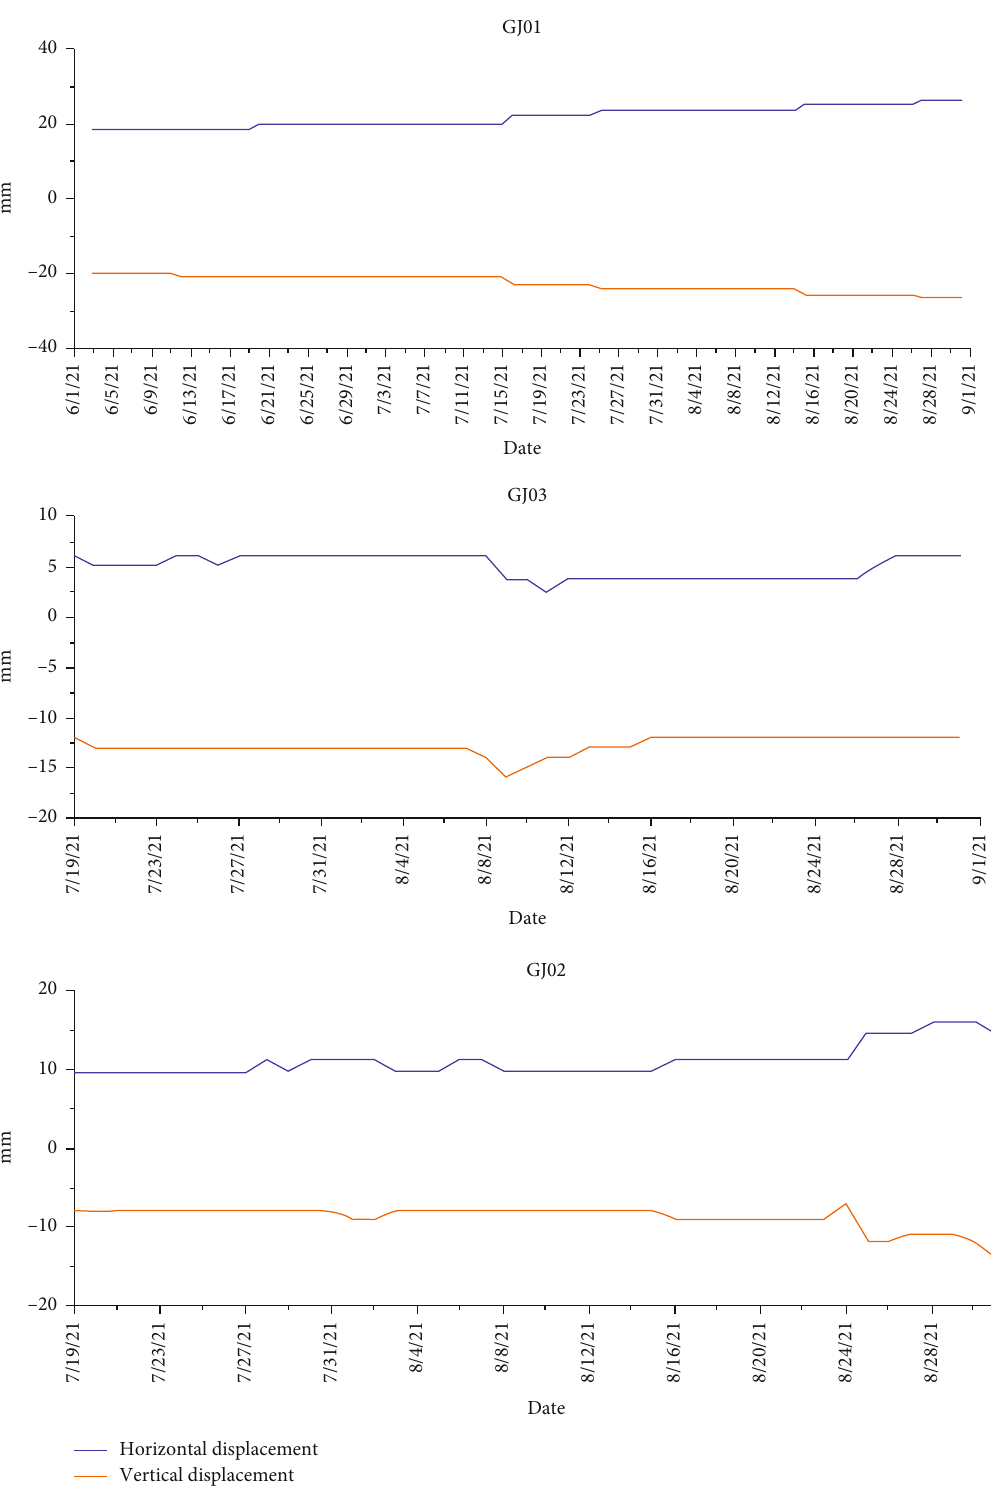
Figure 22: Geological Hazard Monitoring: Monitoring point GJ01 is at the rear edge of the landslide mass; monitoring point GJ02 is north of the landslide mass; monitoring point GJ03 is south of the middle of the landslide